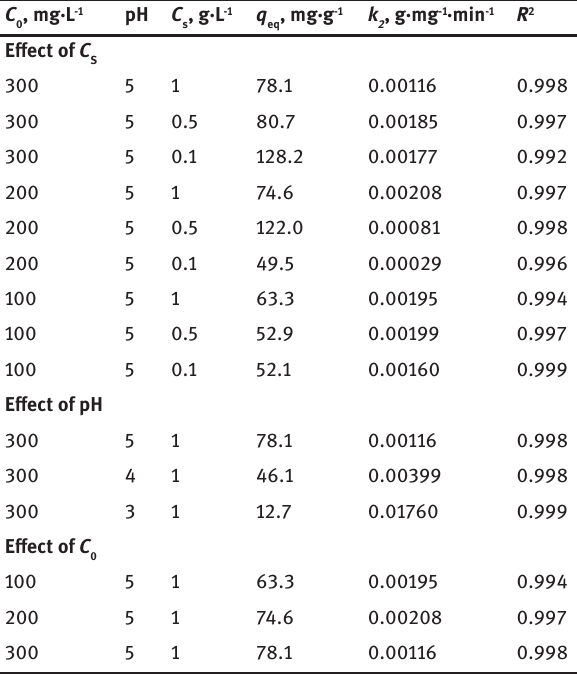
Table 1: The parameters of pseudo-second order model of biosorption kinetics.